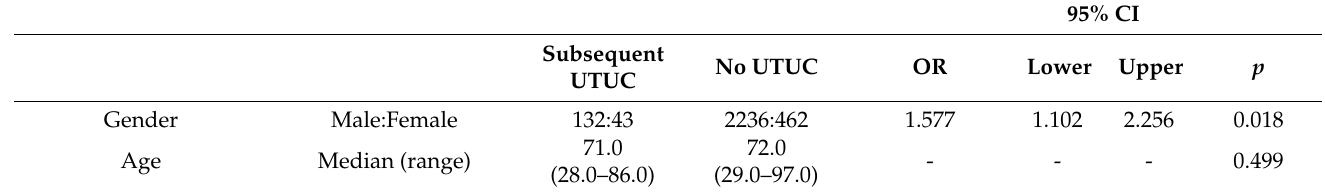
Table 2. Clinical predictive factors for subsequent UTUC after BCG bladder instillation therapy in univariate analysis.